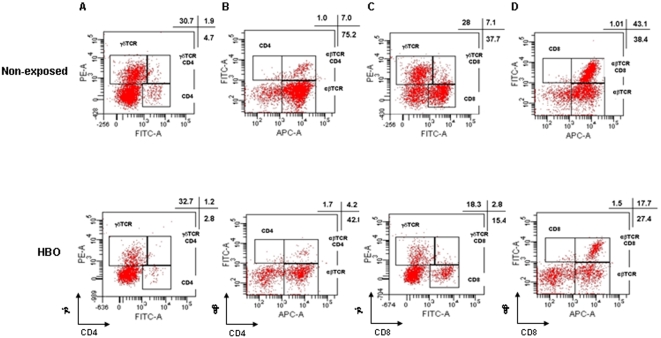
Reduced brain-sequestered T lymphocytes in PbA-infected mice exposed to HBO treatment.Flow cytometric analyses were done on γδ and αβ CD4+ and CD8+ T cells sequestered in mice brains (a pool of 4–5 mice per group) collected on day 7 after PbA infection between the groups regardless of exposure to HBO conditions. Pressurized oxygen therapy reduced the percentage of all cellular subsets, but mainly αβ CD8+ T cells. Representative dot blots of (A) γδ and CD4, (B) αβ and CD4, (C) γδ and CD8, (D) αβ and CD8 double staining.